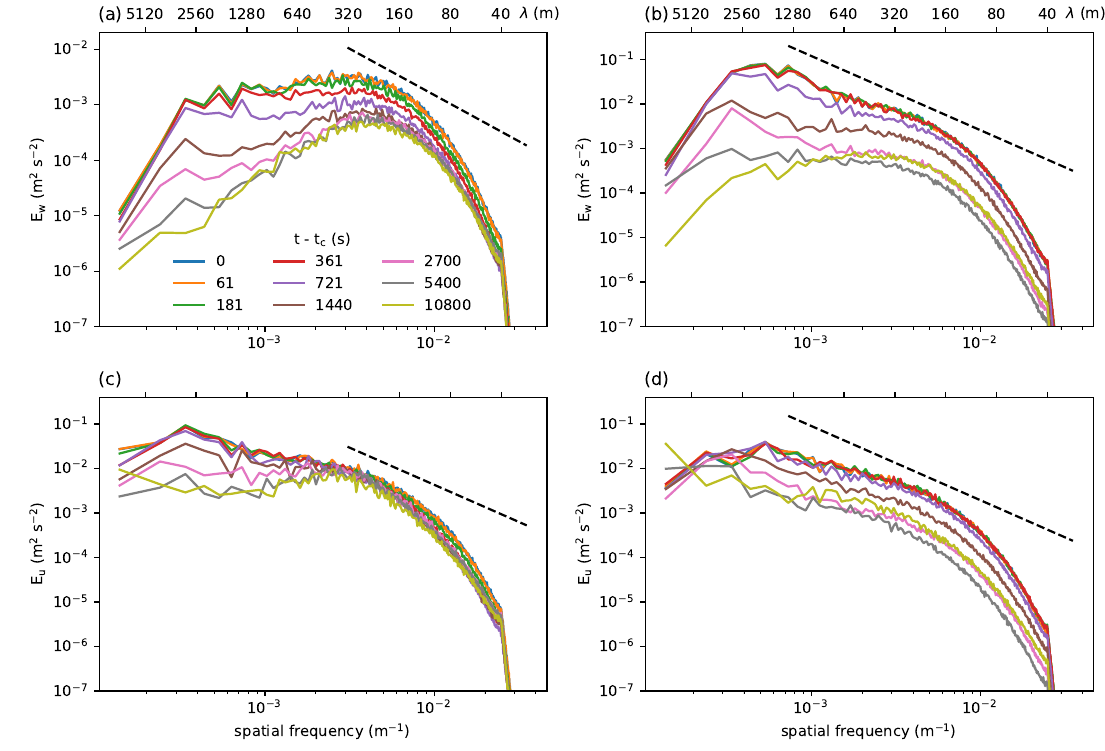
Figure 12. Two-dimensional spectra of vertical velocity at z = ( a ) 40 and ( b ) 480 m and those of streamwise velocity at z = ( c ) 50 and ( d ) 490 m in the advective CBL. Dashed lines of − 5/3 slope are